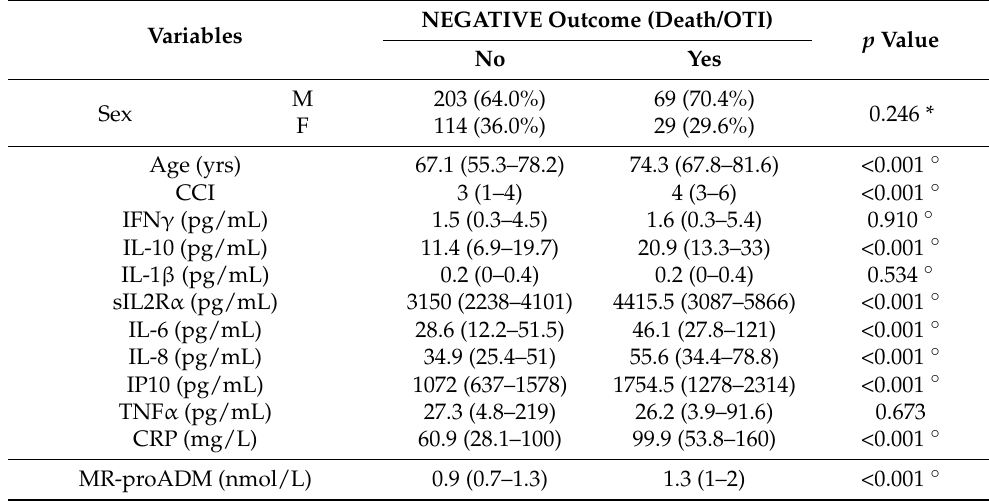
Table 5. Demographics, clinical and laboratory markers in patients with a negative